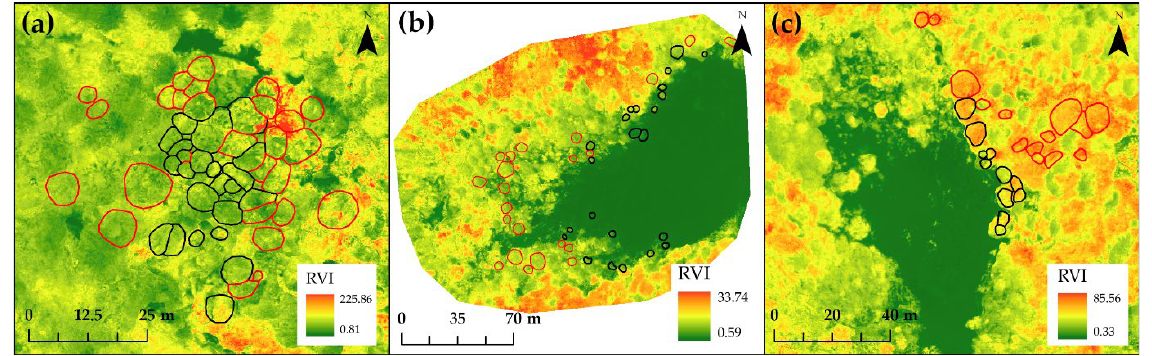
Figure 8. Map of vegetation index RVI for ( a ) Jelovica—16 August 2019, ( b ) Cerkev—4 July 2018, and ( c ) Kekec—3 July 2018 Red tree crowns are uninjured trees, black tree crowns are injured trees.